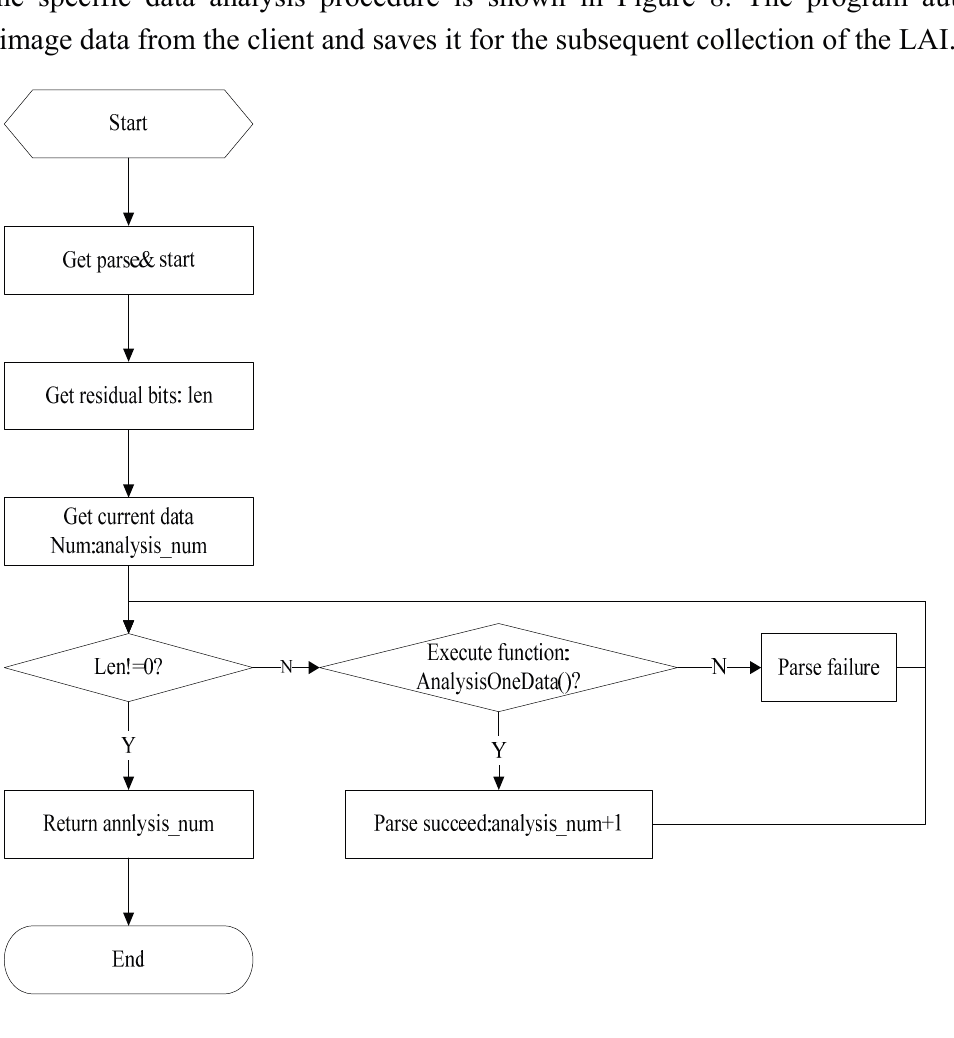
Figure 8. The data analysis